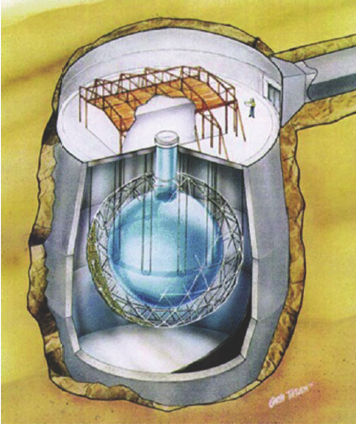
Figure 1: Conceptual architectural scheme of the SNO